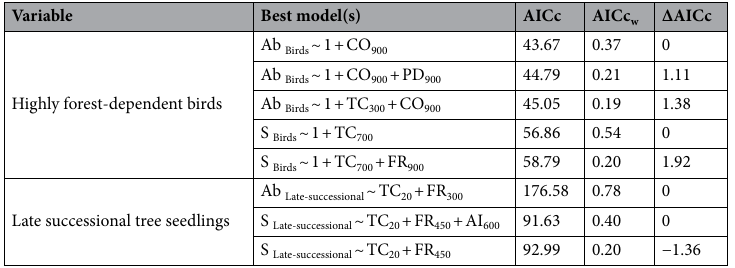
Table 1. Best models (i.e., ΔAIC < 2) for assessing the effects of landscape metrics on bird and tree seedling abundance (Ab) and species richness (S) in restoration plots, in southern Costa Rica. We used qAICc instead of AIC to correct for small sample size (n = 13 for seedlings, n = 12 for birds) and overdispersion. The importance value or AIC weight (AICc w ) for each model as well as the differences in AIC value (ΔAICc) are given for each model. TC tree cover, CO corridor cover, FR fragmentation (i.e., forest patch density), AI forest patches aggregation index.